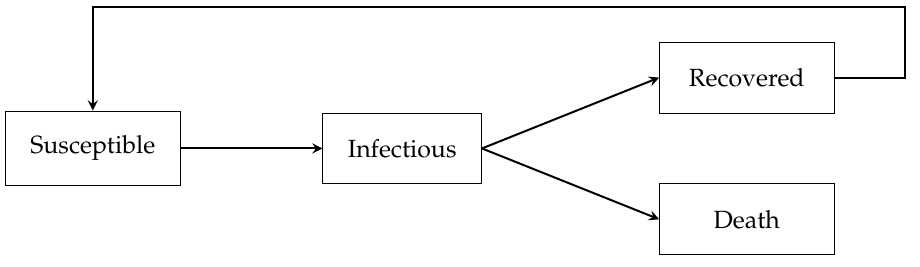
Figure 8. State transition diagrams for COVID-19.